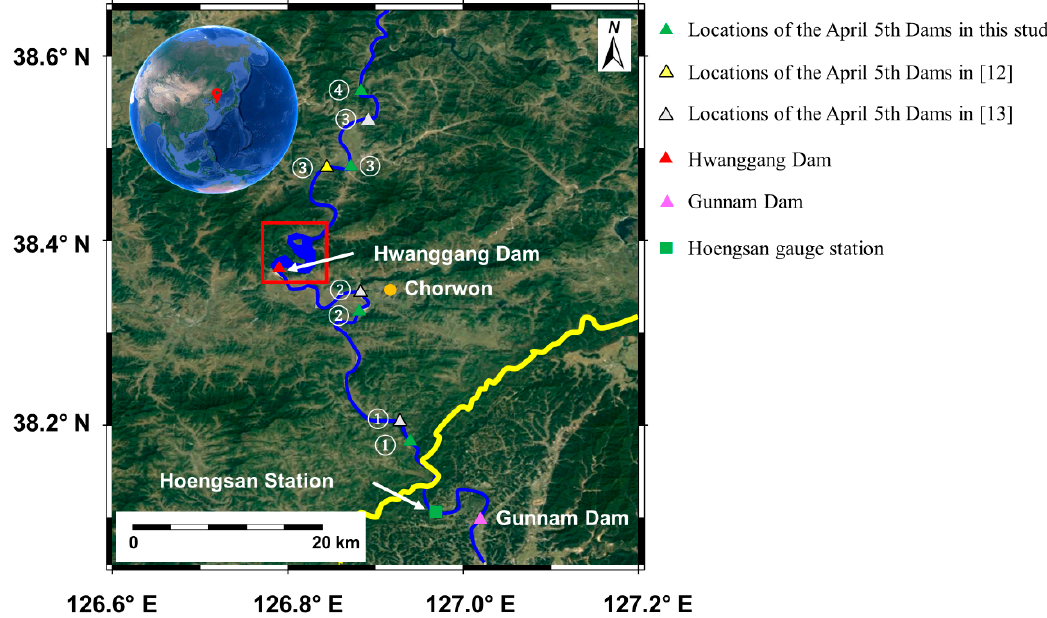
Figure 1. Comparison of the locations of the dams constructed in the Imjin River in the published papers. The circled numbers and triangles indicate the First, Second, Third, and Fourth April 5th Dams and their locations, respectively. Locations of the First, Second, and Third April 5th Dams have been identified differently: the yellow, gray, and green triangles represent their locations identified in [12,13] and this study, respectively. The green square and purple triangle indicate the Hoengsan station and Gunnam Dam in South Korea. The yellow line shows the border boundary between North and South Korea (map data ©2018 Google Earth).